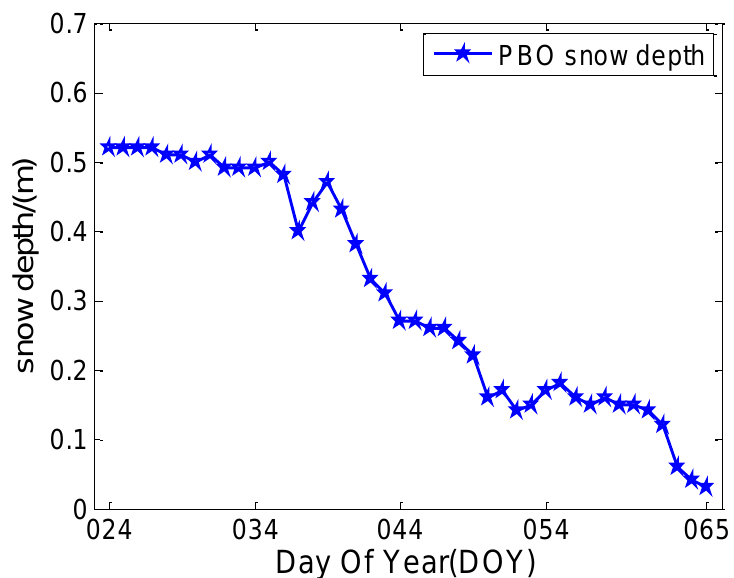
Figure 3. Snow depth of P387 in the experimental period.